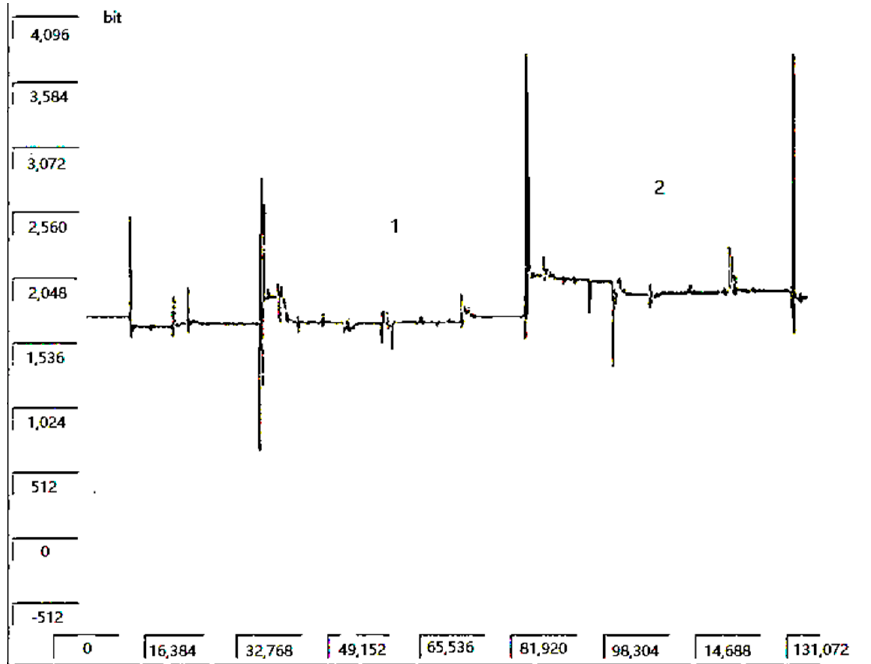
Figure 21. The main roller rotation experiment. Note: 1—graduated arc, and 2—main roller axis.